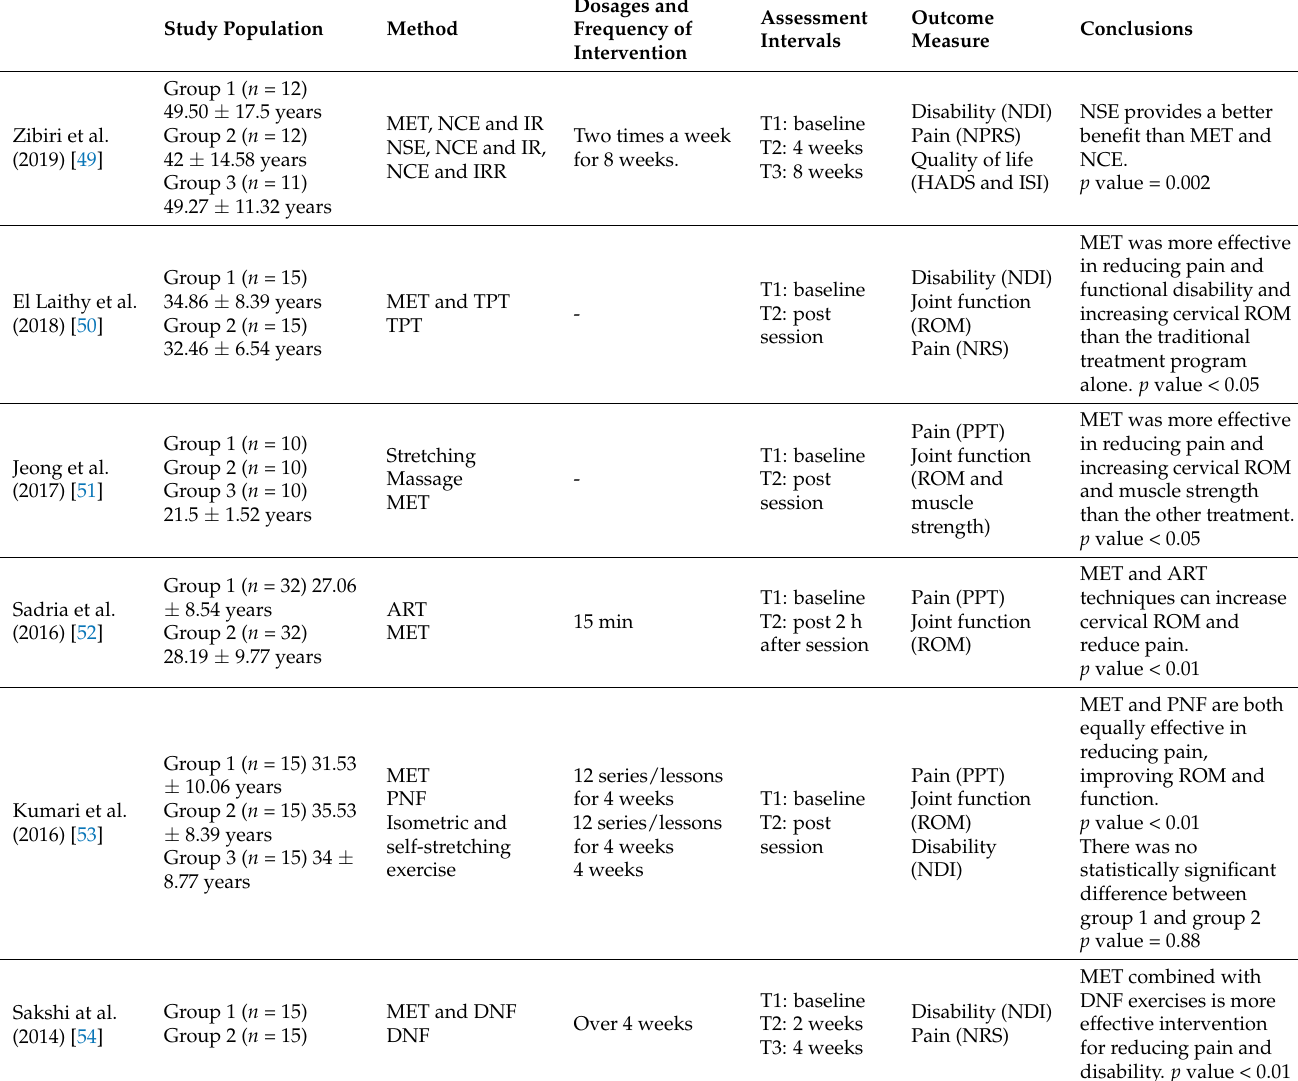
Table 3. Description of intervention in non-specific chronic neck